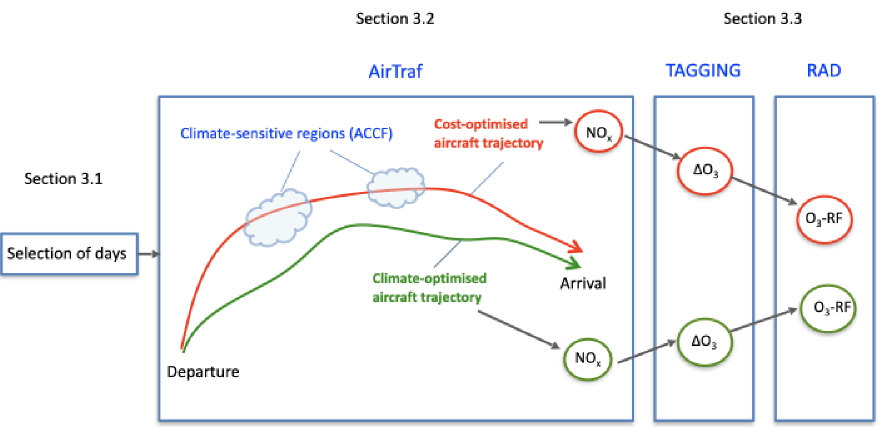
Figure 1. Simulation with used submodels, adapted from [27]. The blocks are labelled with the corresponding section numbers and it also serves as a roadmap for Section